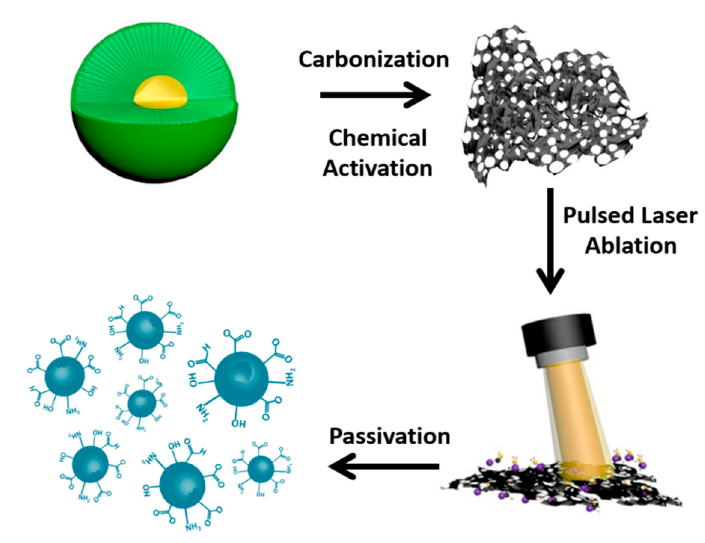
Figure 1. Synthesis process scheme of the N-doped micropore carbon quantum dots (NM-CQDs) derived from waste Platanus biomass.